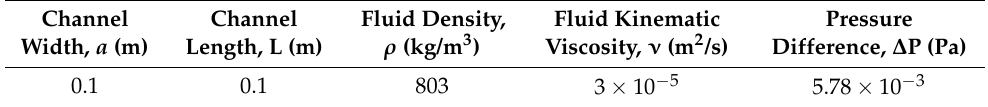
Table 1. Parameters used in the Poiseuille channel flow model.